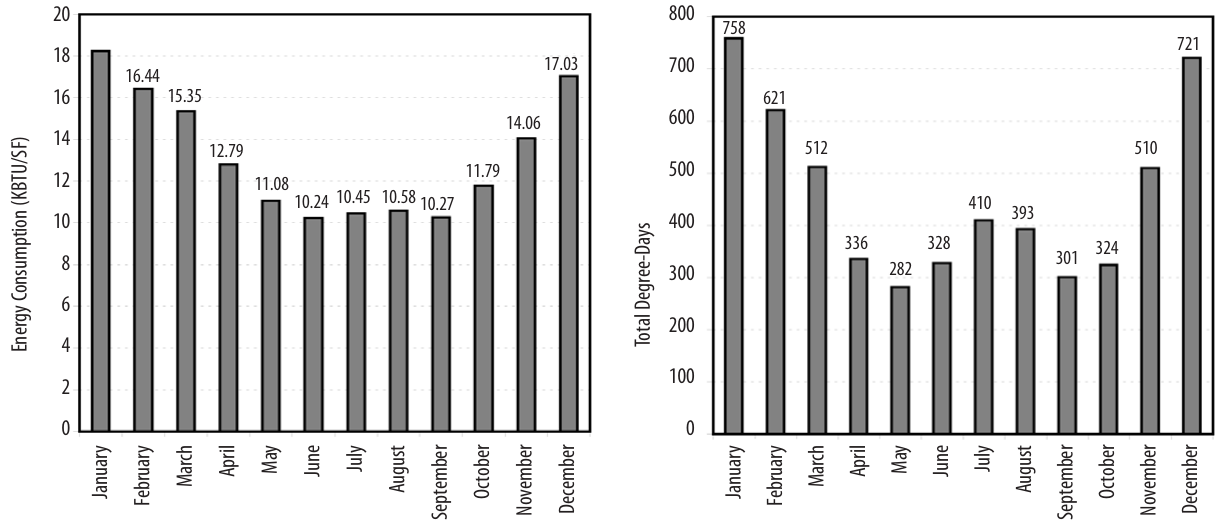
Fig. 4. Mean energy consumption Fig. 5. Monthly mean sum of HDD and CDD Climate Zone 4 Individual